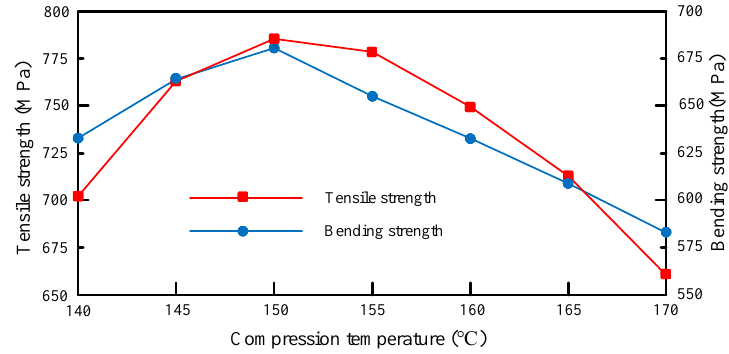
Figure 8. Mapping relationship between compression temperature and mechanical properties.